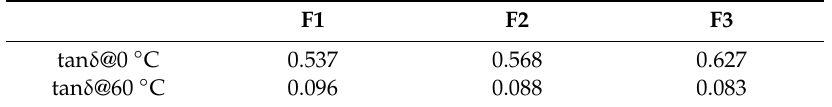
Table 4. tan δ at 0 ◦ C and 60 ◦ C of E25-SSBR / BR composites with di ff erent ratio of ESSBR /